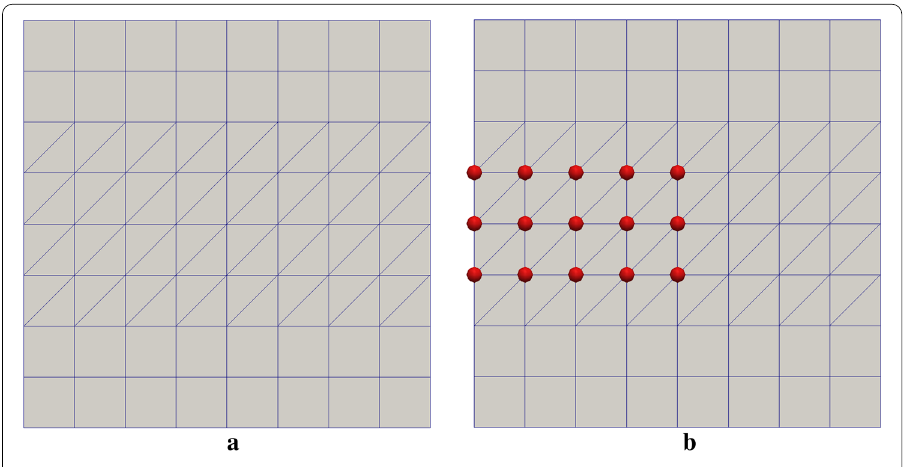
Fig. 7 TRI3 and QUAD4 mesh and singular enrichment adopted for 2-D edge crack problem— a FEM mesh with TRI3 and QUAD4 elements— b nodes enriched with crack tip functions. This figure presents the discretization information for a 2-D edge crack problem with both TRI3 and QUAD4